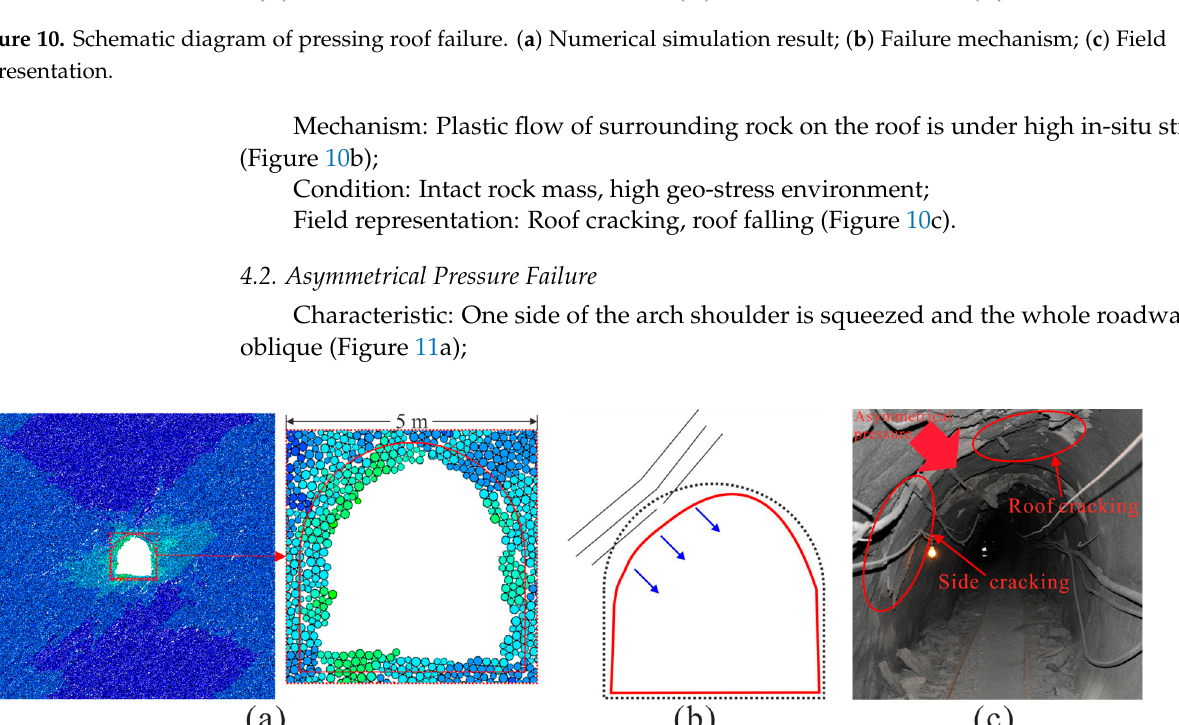
Figure 12. Schematic diagram of pointed roof failure. ( a ) Numerical simulation result; ( b ) Failure mechanism; ( c ) Field representation.